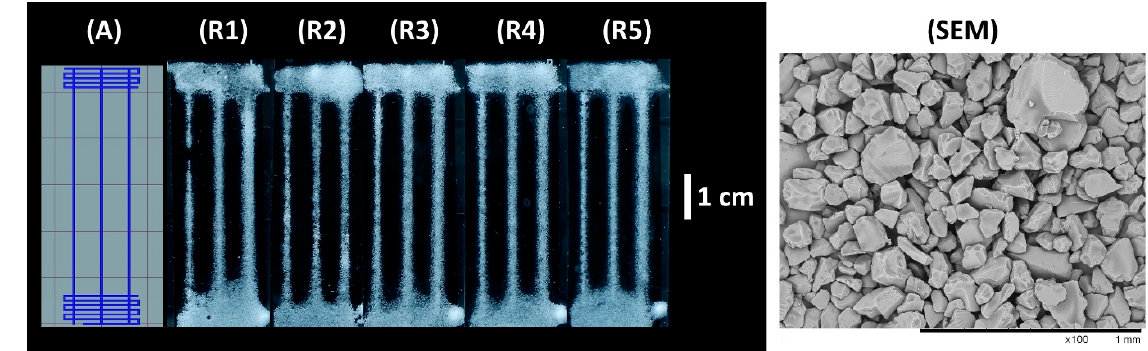
Figure 5. Nozzle movement pattern when printing with DWP ( A ), five replicate prints ( R1 – R5 ), and SEM micrographs of the printed silica gel microparticles with PVAc. The extrusion multipliers used for the three channels were 6×, 10× and 14× from left to right.